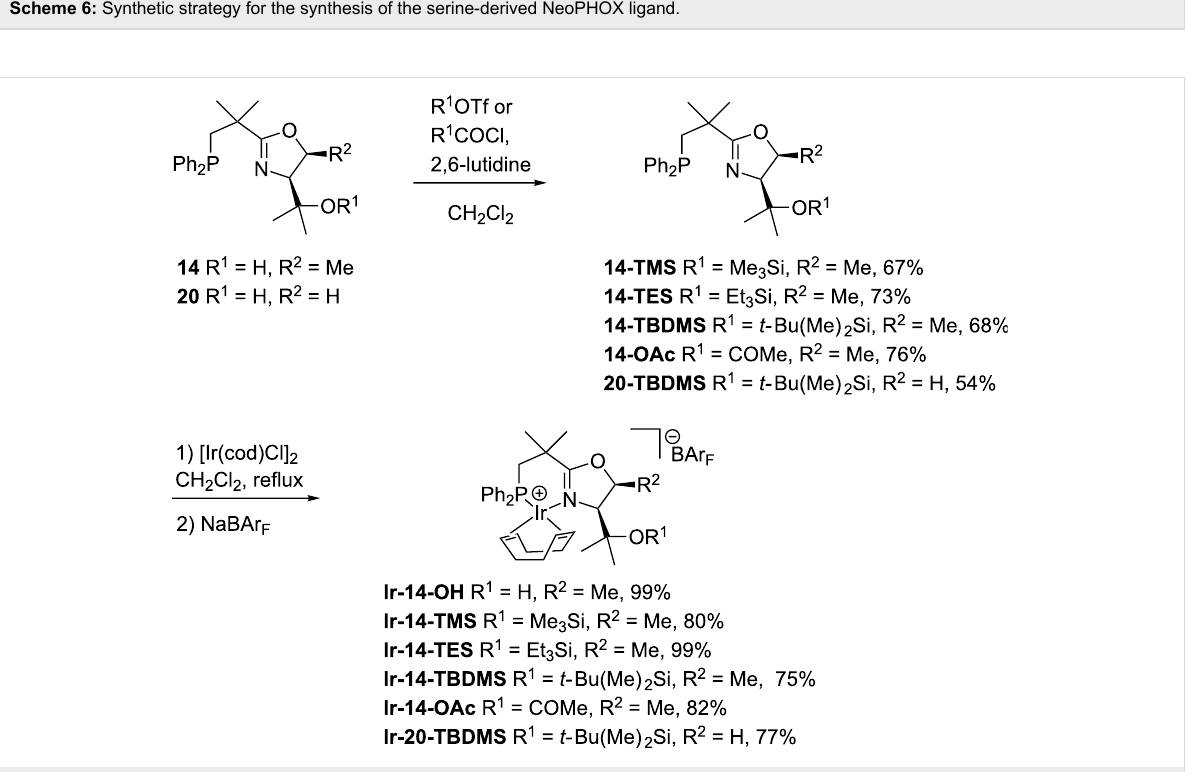
Scheme 7: Derivatization of the 2nd generation NeoPHOX ligands and formation of their iridium